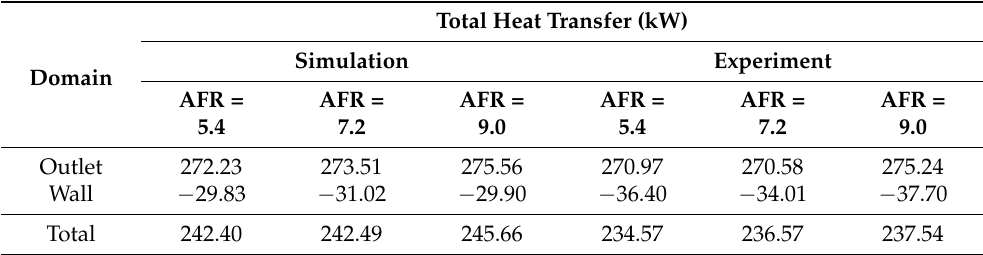
Table 5. Energy analysis of the